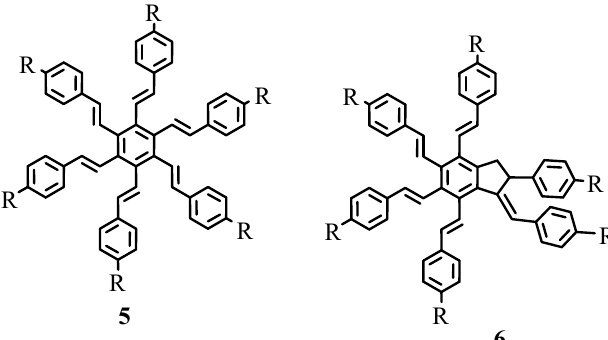
Figure 1. Oligofunctional and oligocyclic products formed via Heck reaction.